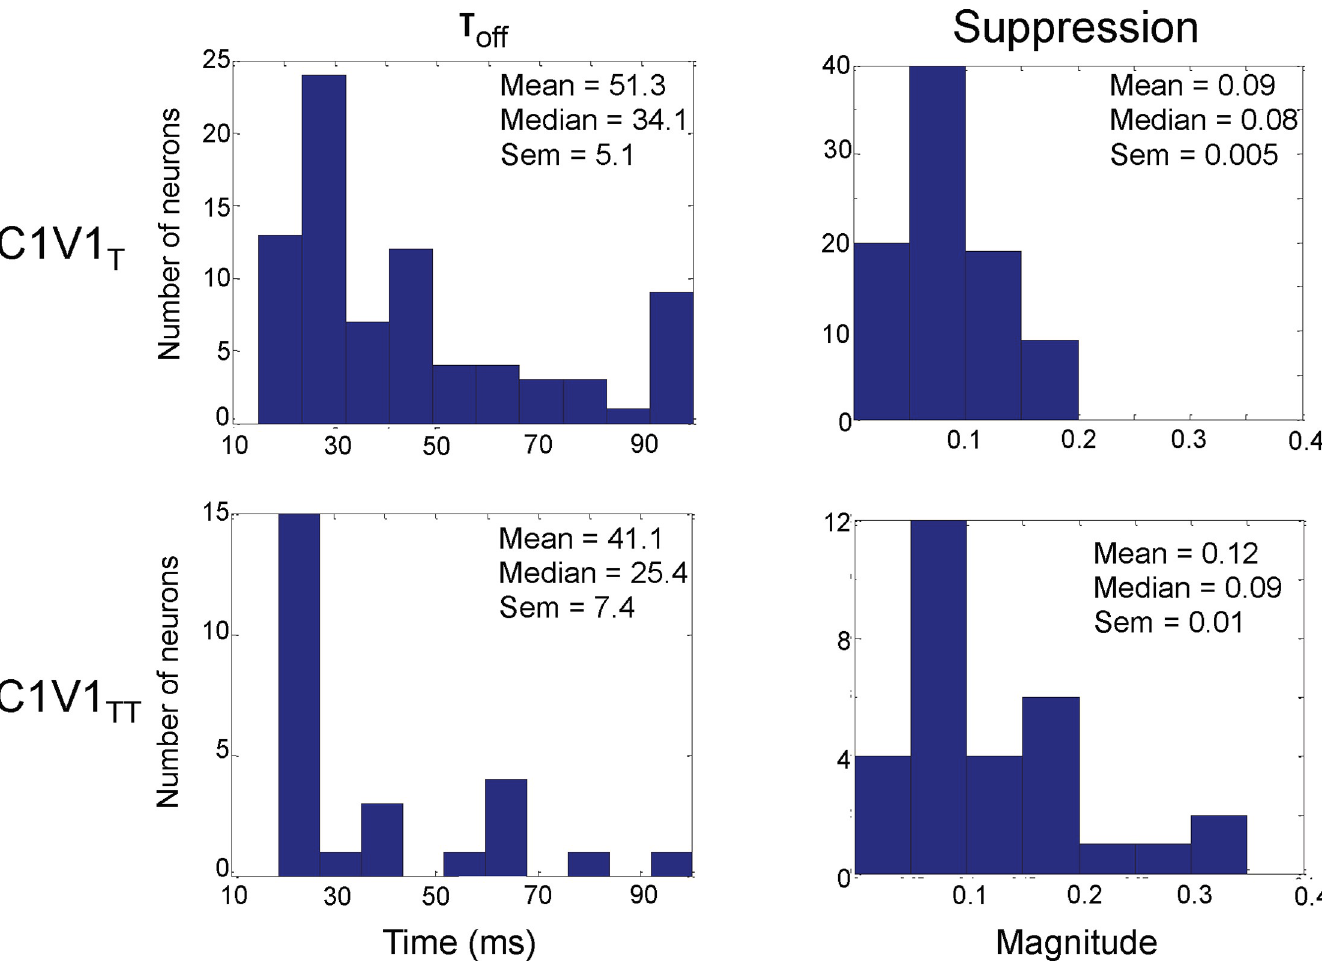
Fig 8. Magnitude and speed of suppression of neuronal responses to stimulation of C1V1 TT and C1V1 T opsins in macaque V1. Comparing the histograms of the off response and magnitude of suppression of the C1V1 TT and C1V1 T on a cell-by-cell basis, we see that the faster opsin (C1V1 TT ) has a significantly faster off response (left) and a stronger magnitude of suppression (right) as predicted by the model.